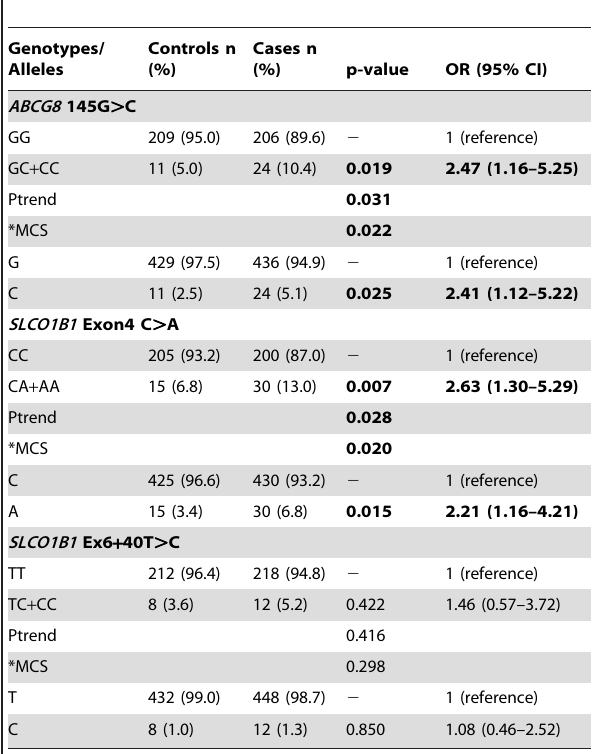
Table 3. Hepatocanalicular transporter pathway.